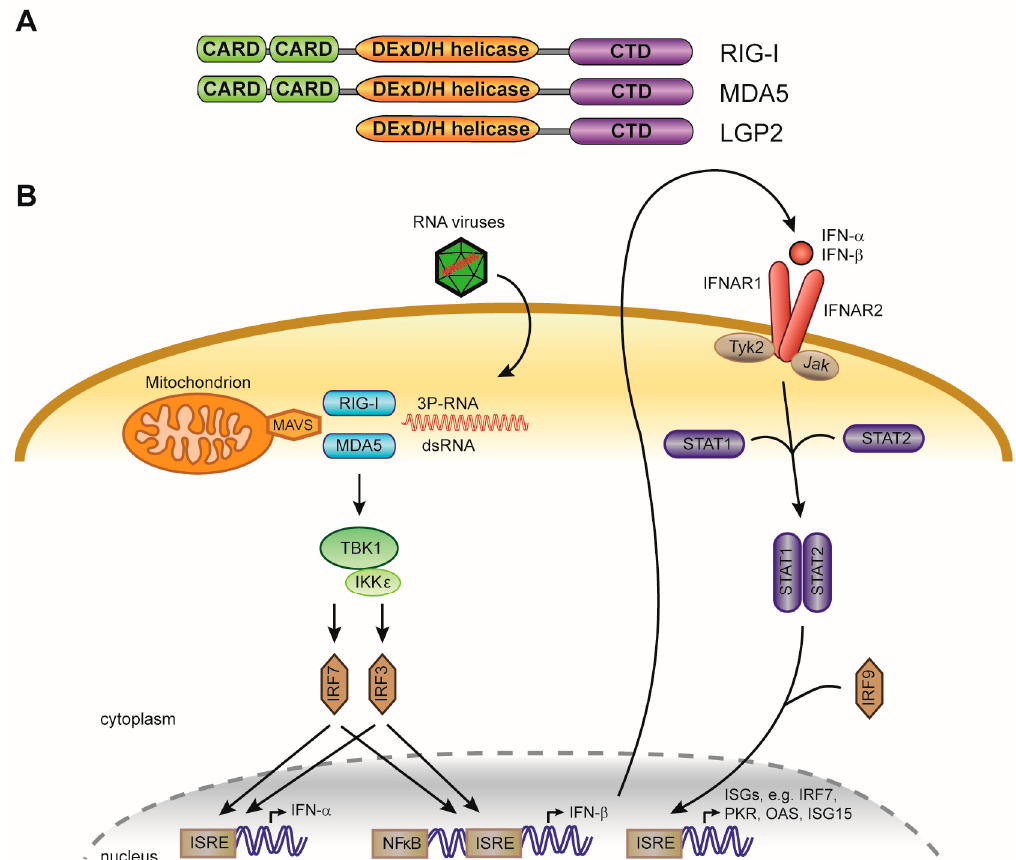
Figure 5. Cytosolic recognition of foreign nucleic acids and activation of interferon stimulated genes (ISGs). ( A ) Domain structure of the cytosolic RNA sensors RIG-I and MDA5, showing the CARD signaling domain, the DExD / H-box helicase domain, and the C terminal domain (CTD). LGP2 lacks the CARD signaling domain. ( B ) Schematic representation of the interferon response in mammals. RIG-I and MDA5 recognize non-self viral RNA signatures, including the presence of a 5’ triphosphate moiety on RNA (3P-RNA) or long dsRNA. Upon detection of foreign nucleic acids, the CARD domains transduce the signal to mitochondrial antiviral-signaling protein (MAVS) located at mitochondrial membranes, leading to the phosphorylation and activation interferon response factors (IRF) 3 and 7. Upon activation, IRF3 and IRF7 form homodimers and translocate to the nucleus, where they bind Interferon-Stimulated Response Elements (ISRE) to activate transcription of type I interferons (IFN- α and IFN- β ). Type I IFNs translocate across the cell membrane, after which they signal in a paracrine or autocrine manner via the interferon- α / β receptor (consisting of two subunits, IFNAR1 and IFNAR2). This activates the JAK-STAT pathway, leading to phosphorylation of STAT transcription factors (signal transducer and activator of transcription). Phosphorylated STAT1 and STAT2 heterodimerize, and translocate to the nucleus to activate expression of broad range of ISGs.